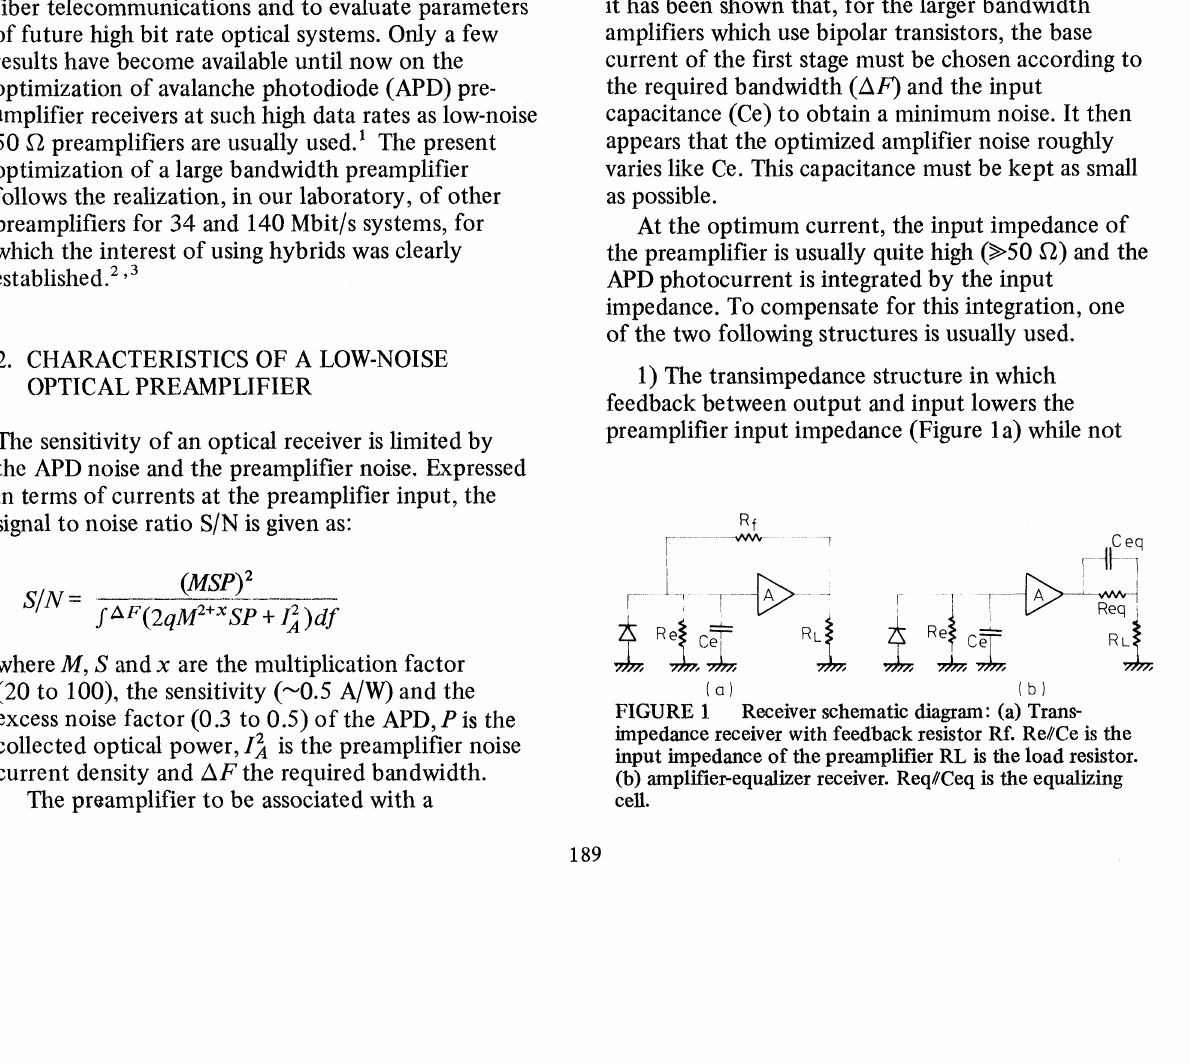
Receiver schematic diagram: (a)Trans- impedance receiver with feedback resistor Rf. Re//Ce is the input impedance of the preamplifier RL is the load resistor. (b) amplifier-equalizer receiver. Req//Ceq is the equalizing cell.